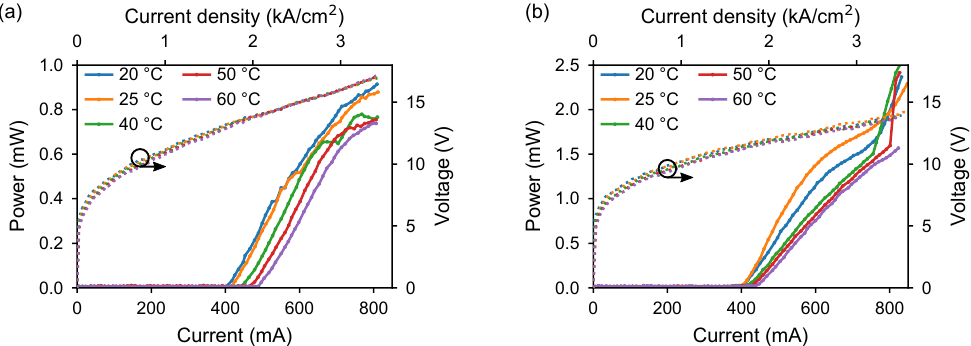
Figure 5. Light-current-voltage (LIV) dependence on temperature for ( a ) DFB and ( b ) DBR